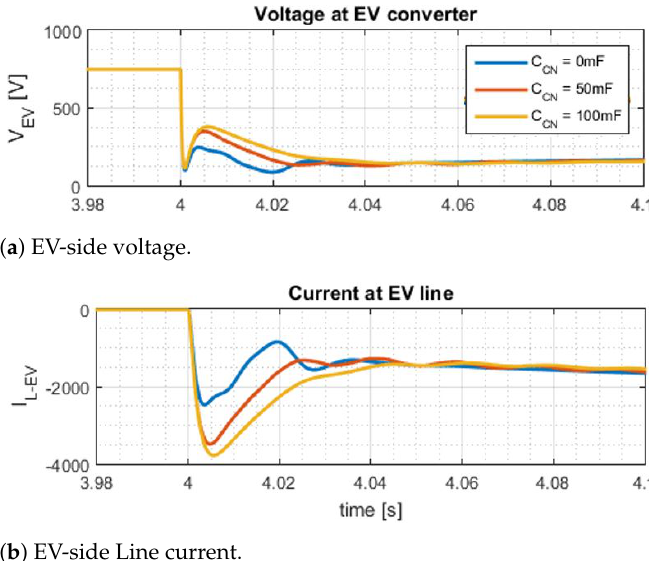
Figure 15. Response with EV-side